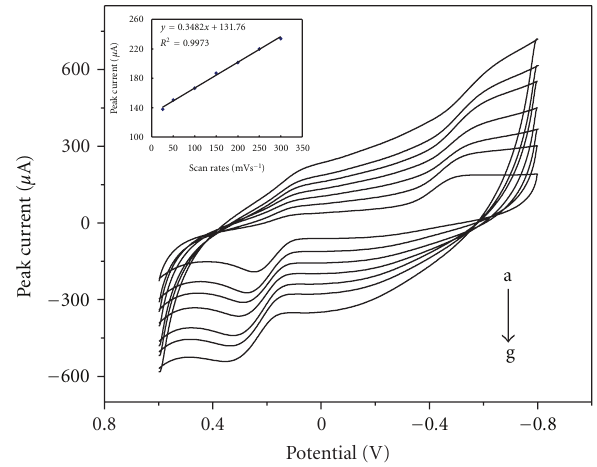
Figure 4: Cyclic voltammograms obtained at PVP/CPE in 0.05 molL − 1 PBS with various scan rates. The scan rates were 25, 50, 100, 150, 200, 250, 300 mV/s from a to g. Inset: plot of the peak current as a function of the scan